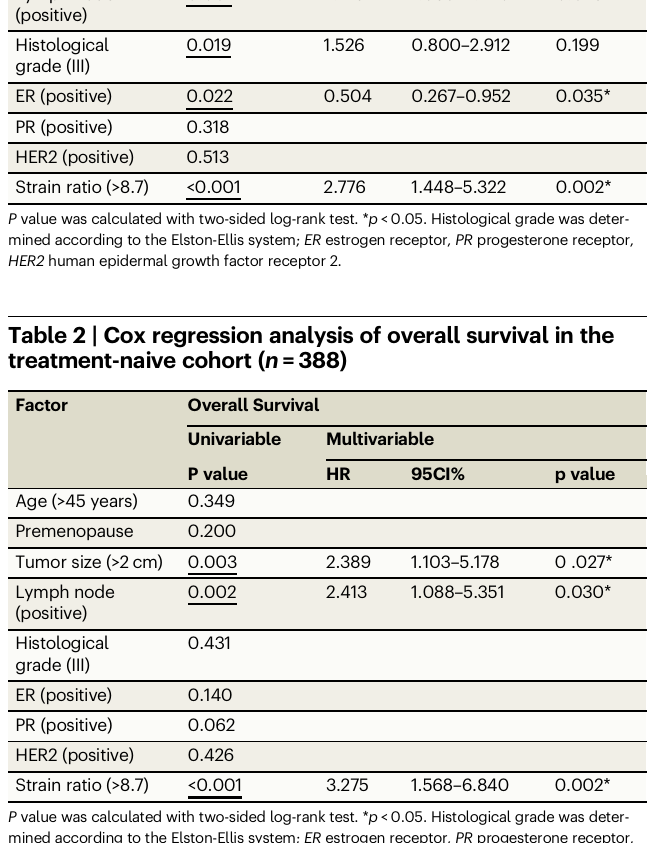
Table 1 | Cox regression analysis of disease-free survivalin the treatment-naive cohort ( n = 388) Factor